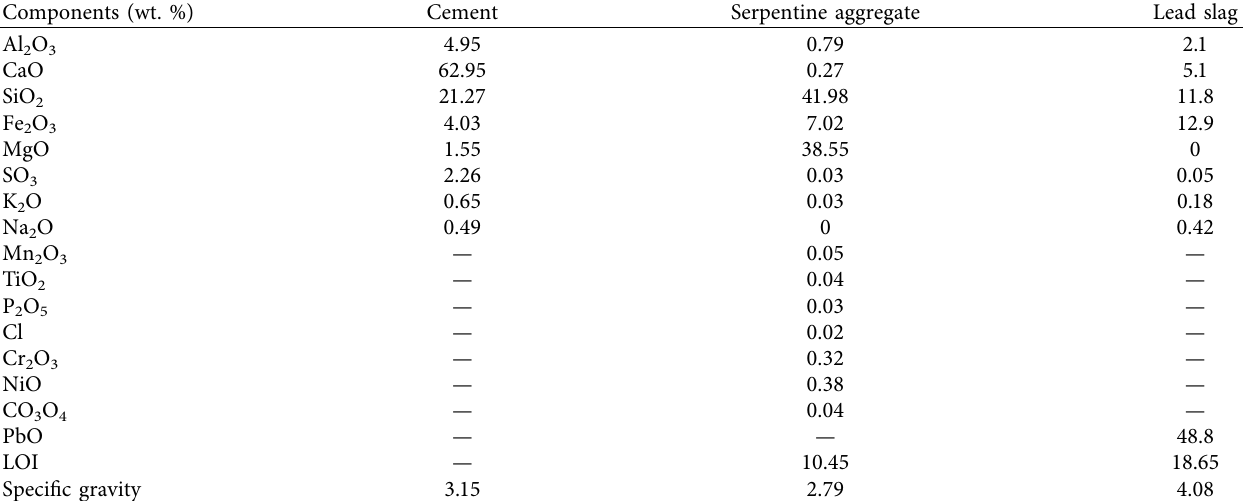
Table 1: Te chemical attributes of the materials.